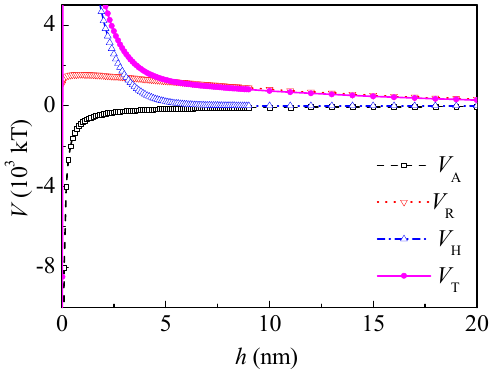
Figure 6. Potential energy between kaolinite and coal particles after adsorption of PAM A401.